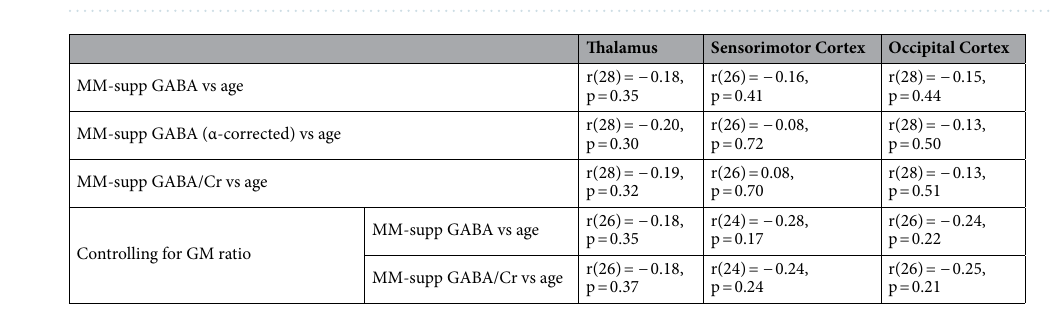
Figure 3. Correlations between the three versions of MM-supp GABA levels and age. ( a ) Correlation between MM-supp GABA and age. ( b ) Correlation between α-corrected MM-supp GABA and age. ( c ) Correlation between MM-supp GABA/Cr and age. TH: Thalamus (red); SM: Sensorimotor cortex (green); OC: Occipital cortex (blue).